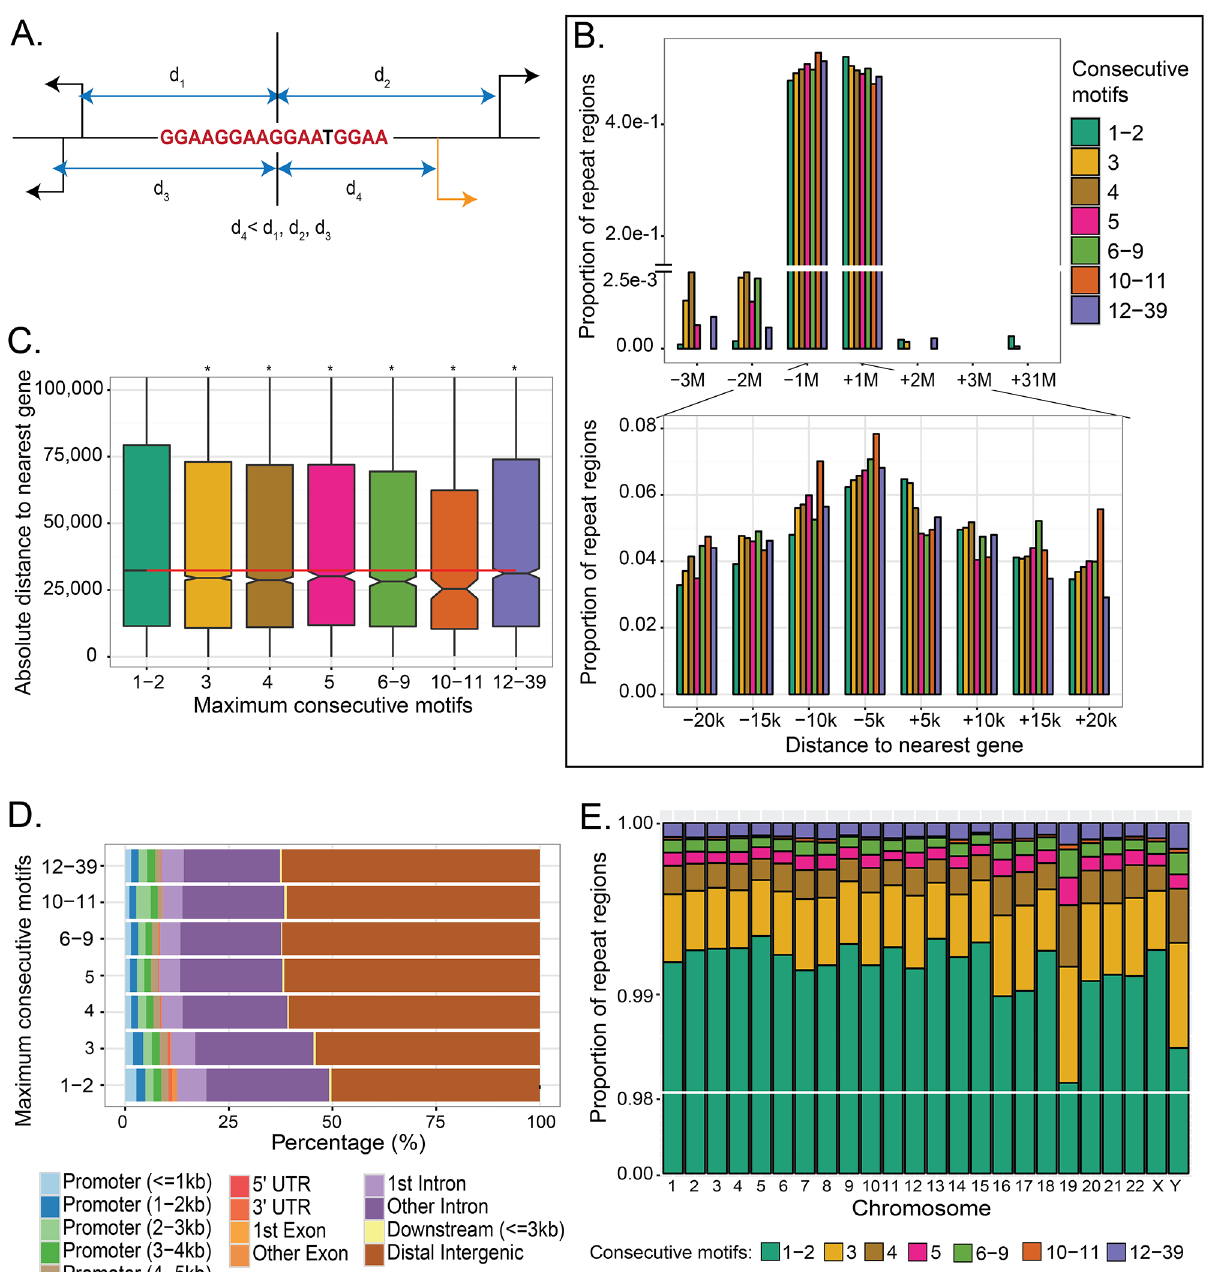
Fig 2. Nearestgene schemaand genomic location of repeat regions. ( A )Schema showing the nearest gene(orange)whichis the gene with the shortest distancecalculatedfrom its TSS to the middleof the repeatregion.( B )Distribution of distances to nearestgenesfor each repeat regiongrouped by numberof consecutive motifs. The sum of percentages for each consecutive motif is 100%. ( C )Comparisons of distance-to-nearest-gene for longerconsecutive motifs to repeat regionswith one to two consecutive motifs (i.e. ‘1–2’). * indicates the repeat regionsare significantly closer to a genethan repeat regionswith 1–2 consecutive motifs ( p < 0.05). Red line represents the mediandistance- to-nearest genefor repeat regionswith 1–2 consecutive motifs. ( D )Feature distribution for each consecutive motif category. ( E )Proportions of repeat regionsin eachchromosome groupedby the number of consecutive motifs.